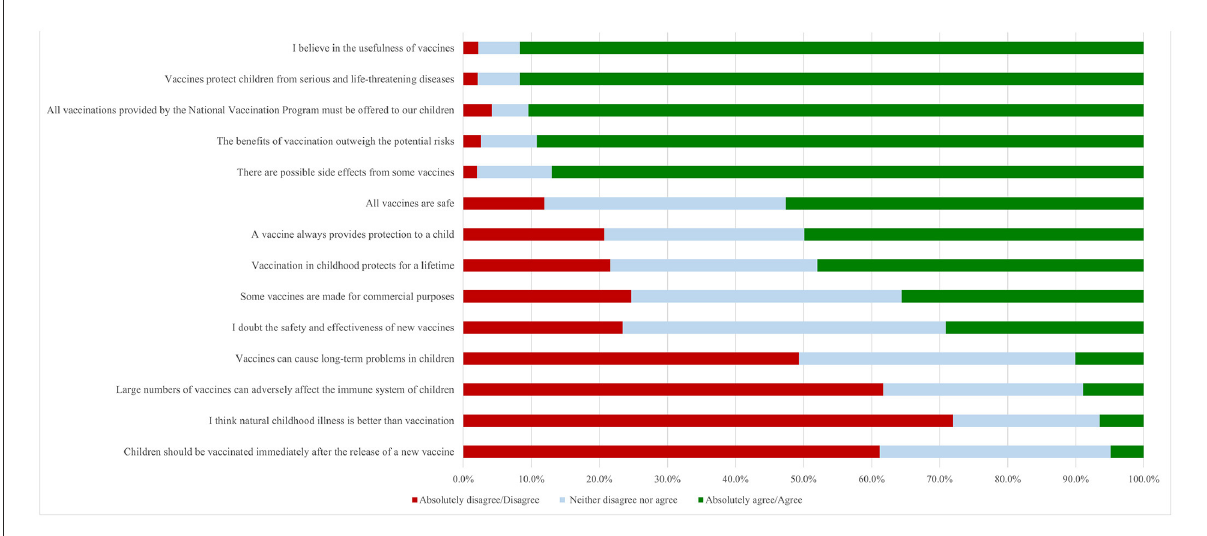
FIGURE1 Maternal responses to questions about vaccination attitudes and